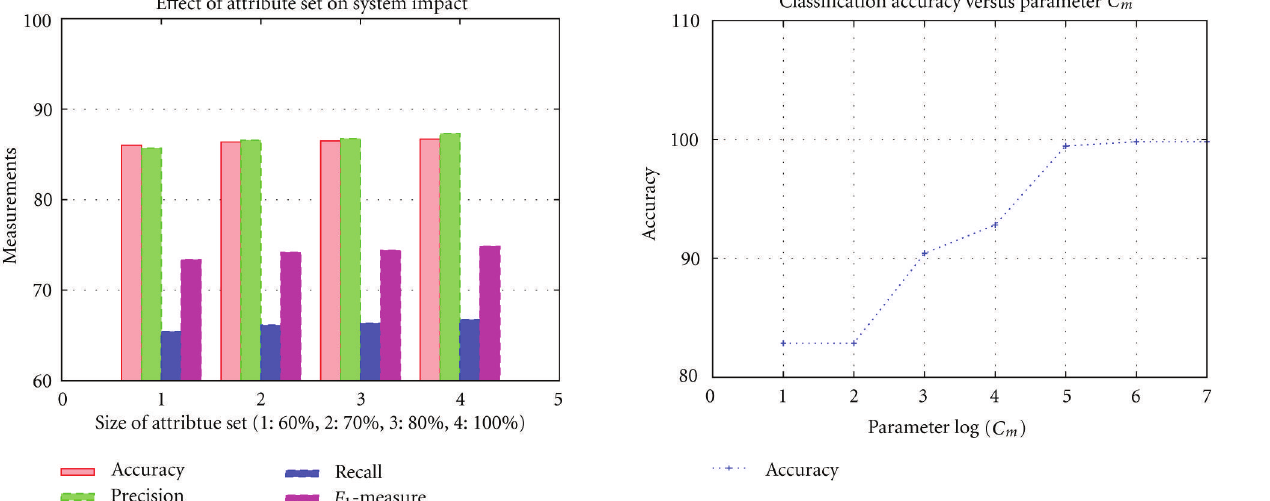
Figure 13: Relation between parameter C m and accuracy on